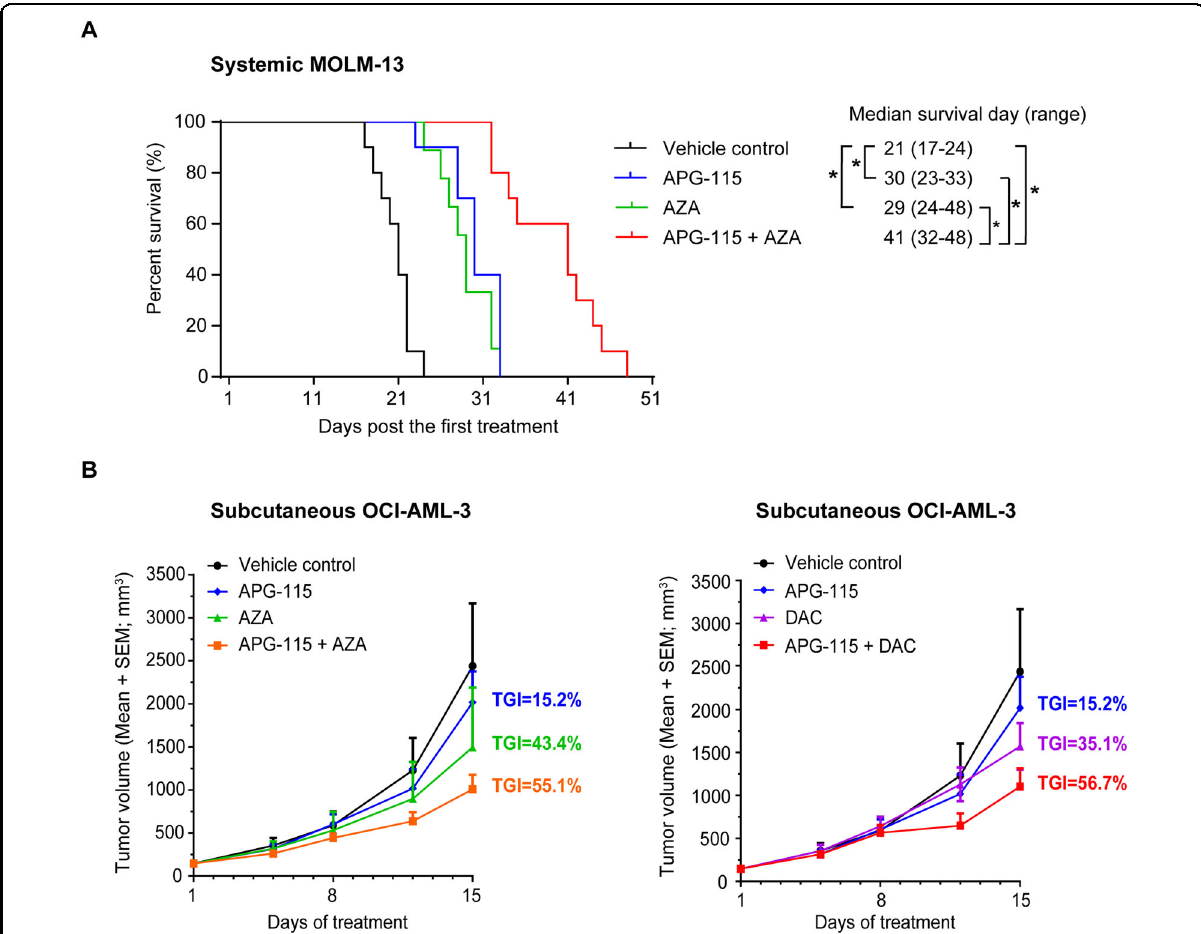
Fig. 4 APG-115 enhances the antileukemic activity of AZA or DAC in AML xenograft models. Three days after cell implantation, mice were treated with APG-115 (50 mg/kg, PO, QD), AZA (2 mg/kg, IV, QD), the combination, or vehicle for 7 days. A Kaplan – Meier curves show that APG-115 combined with AZA conferred signi fi cantly prolonged survival compared to any single agent in a systemic MOLM-13 AML xenograft model of NOD SCID mice ( n = 10 per group): 41 days with APG-115-AZA compared to 30 days with APG-115, 29 days with AZA, and 21 days with the vehicle (* p < 0.05 for each comparison of APG-115 ‒ Aza with single agents or vehicle by log-rank test). B APG-115 potentiates the growth-inhibitory effects of AZA and DAC in NOD SCID mice bearing subcutaneous OCI-AML-3 xenograft tumors. Mice were treated with APG-115 (50 mg/kg, PO, QOD for 15 days), AZA (2 mg/kg, IV, QD for 7 days), DAC (1 mg/kg, IV, QD for 7 days), or combinations as indicated ( n = 5 per group). Tumor growth inhibition (TGI) was calculated at the